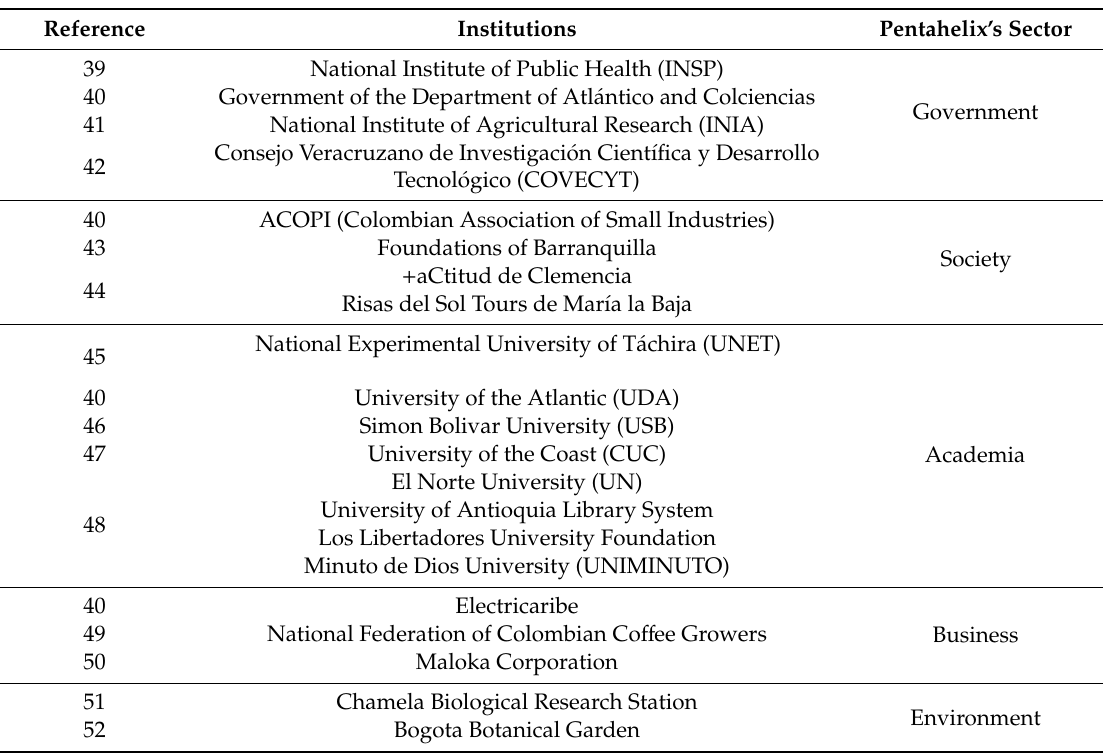
Institutions that had developed experiences of SAK, classified according to the pentahelix’s